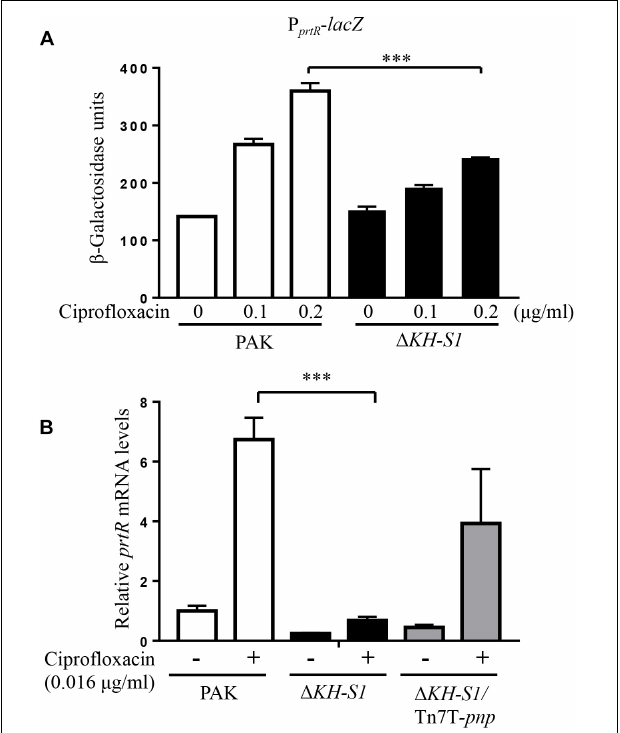
FIGURE 4 | The promoter activity and mRNA level of prtR in the (cid:49) KH-S1 mutant. (A) Expression of P prtR - lacZ in PAK and the (cid:49) KH-S1 mutant. The bacteria were grown to an OD 600 of 0.5, and then treated with ciprofloxacin at indicated concentrations for 3 h, followed by the β –galactosidase assay. ∗∗∗ p < 0.001 by Student’s t -test. (B) PAK, (cid:49) KH-S1 and the complemented strain were grown to an OD 600 of 0.8–1.0 at 37 ◦ C with or without 0.016 µ g/ml ciprofloxacin. The mRNA levels of prtR were determined by real-time PCR with rpsL as the internal control. ∗∗∗ p < 0.001 by Student’s t -test.